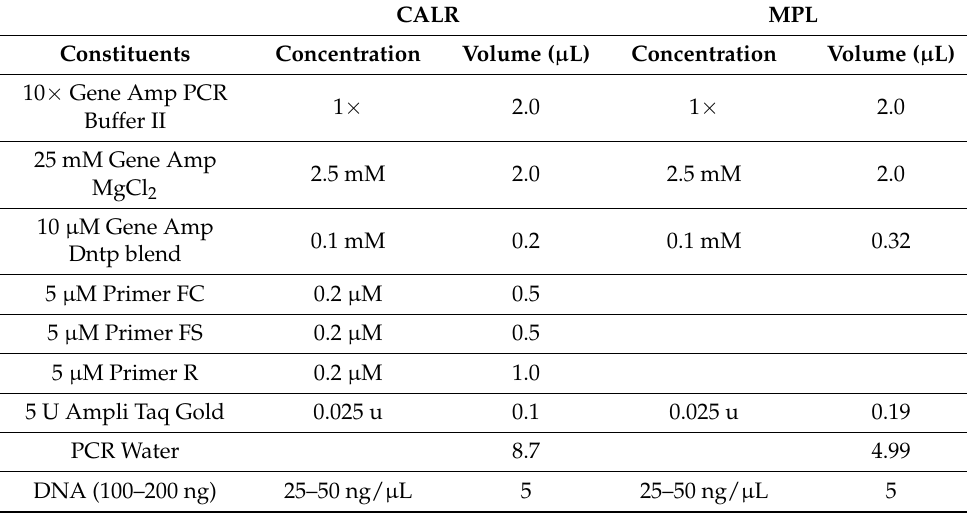
Table A4. Constituents for PCR and its